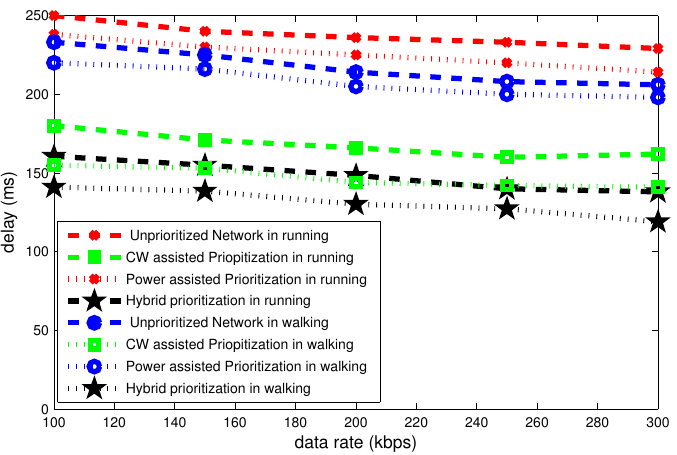
Figure 20. Effect of data rate on delay in mobile